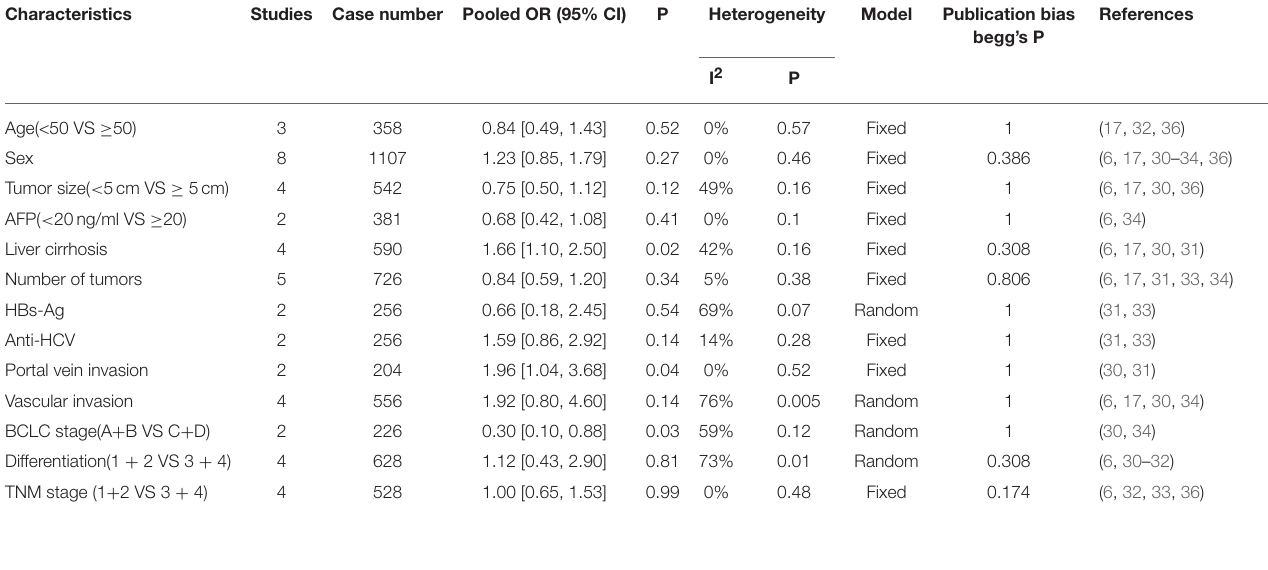
TABLE 2 | The relationship between high PD-L1 and the clinicopathological features.